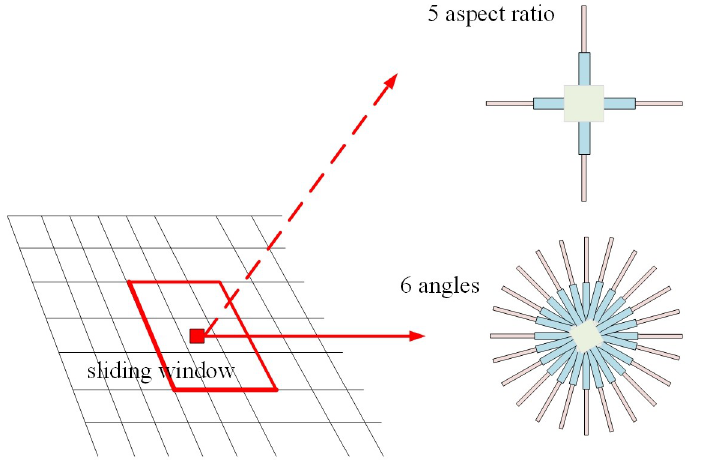
Fig 6. Schematic of the specific rotation